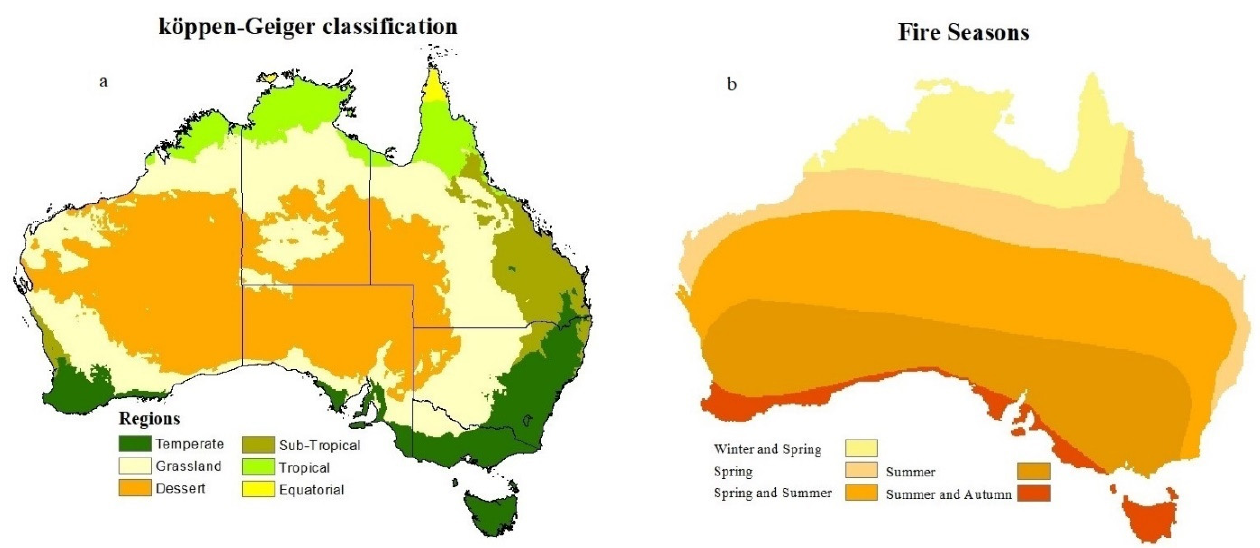
Figure 1. Stratification of Australia into ( a ) vegetation types based on temperature and rainfall using the Koppen-Geiger regional classification ( b ) fire seasons.